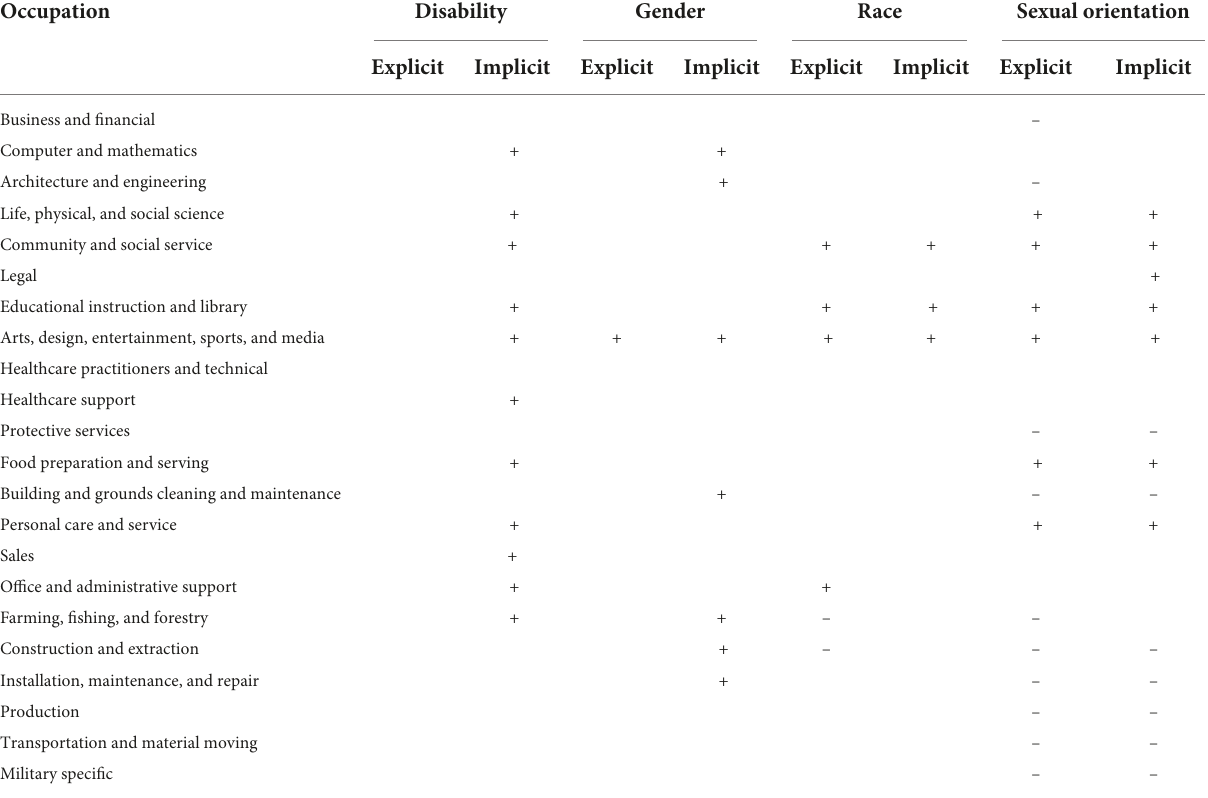
TABLE 3 Summary of differences in explicit and implicit biases between people in management occupations and people in other occupations. Occupation Disability Gender Race Explicit Implicit Explicit Implicit Explicit